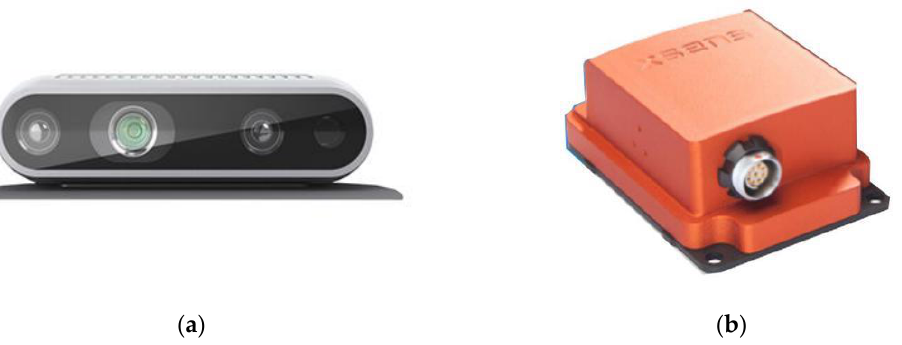
Figure 18. Instruments and equipment used for image capture. ( a ) RealSense D435, and ( b ) XSENS MTi-300.